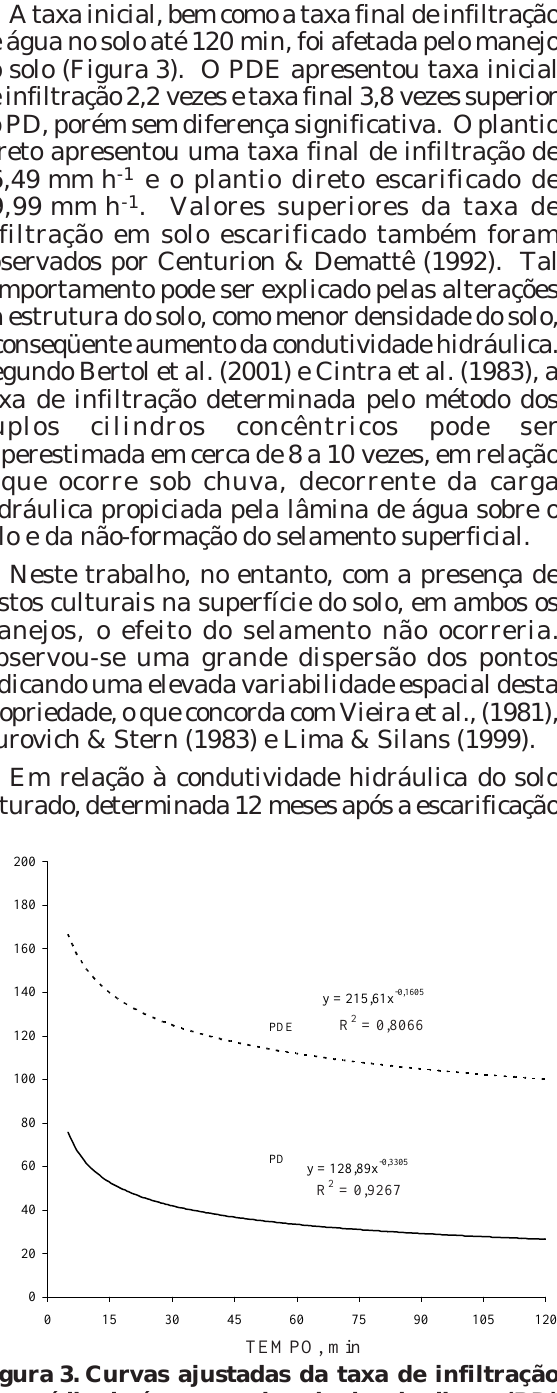
Figura 3. Curvas ajustadas da taxa de infiltração média da água no solo sob plantio direto (PD) e plantio direto escarificado (PDE), seis meses após a